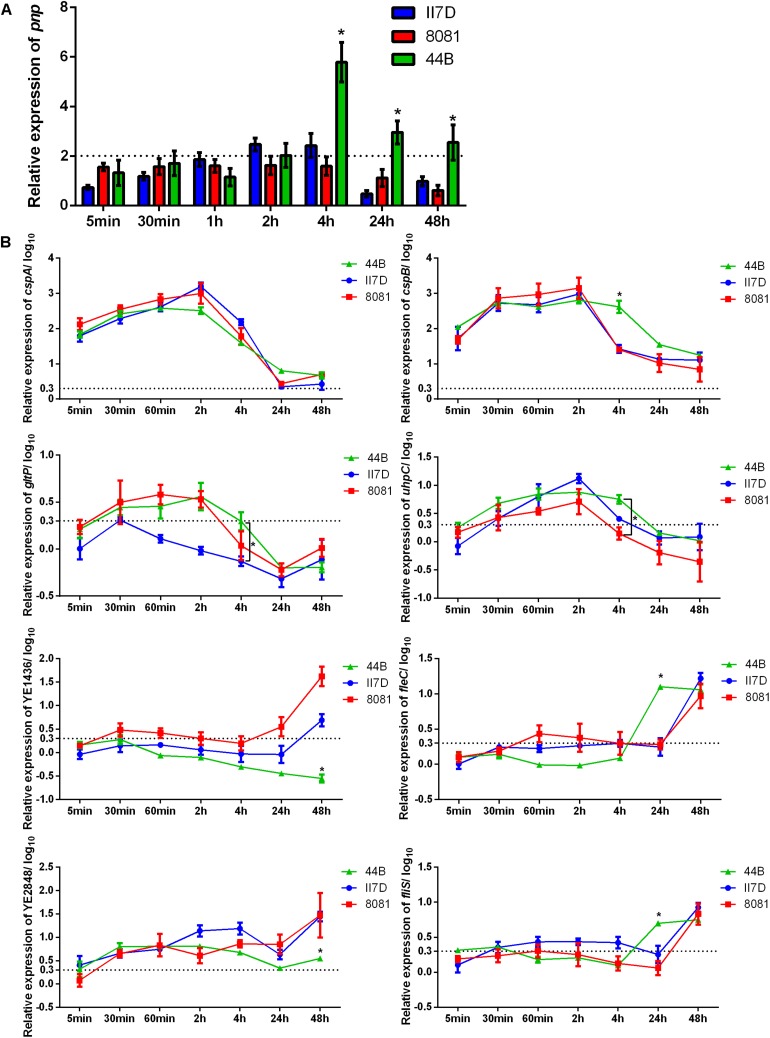
Expressional changes of the cold-responsive genes in II7D, 44B, and 8081. Three Y. enterocolitica strains were incubated at 4°C over time (from 5 min to 48 h) to show the expressional changes in cold response. Gene expression was normalized to the reference genes polA. (A) Expressional changes of pnp gene of three isolates at 4°C. Specific values are shown as the means ± SEM of the relative expression in four independent experiments. (B) Expressional changes of cspA, cspB, gltP, uhpC, YE1436, fliS, fleC, and YE284 genes at 4°C in three isolates. Specific values of relative gene expression are shown in log10 as the means ± SEM of four independent experiments. Statistically significant difference compared with the control according to multiple comparisons (∗p < 0.05). The line parallel to the x-axis represents a biologically relevant induction at 2 (fold-change) and 0.3 (log10 fold-change).